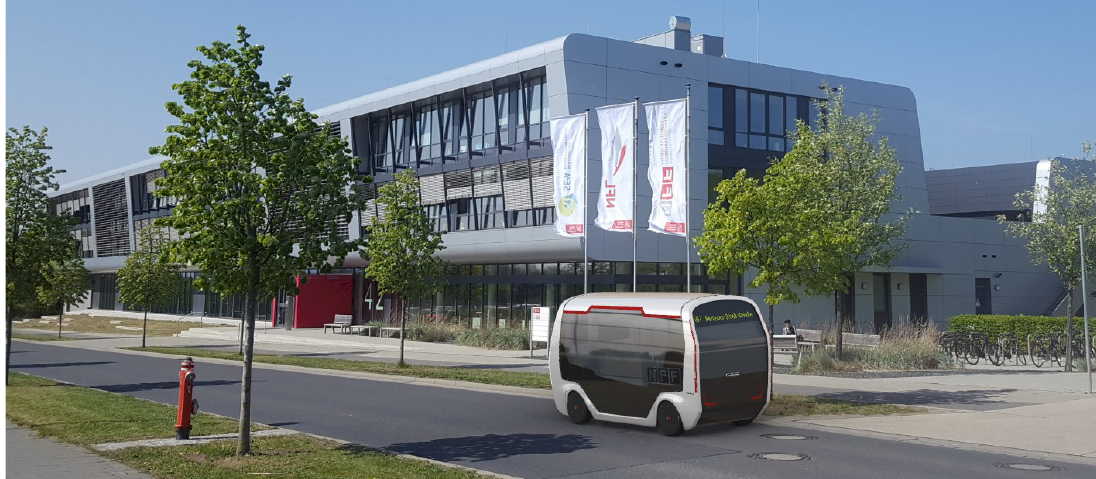
Figure 3. Concept for the dynamically configurable autonomous vehicle with the NFF-people mover module.